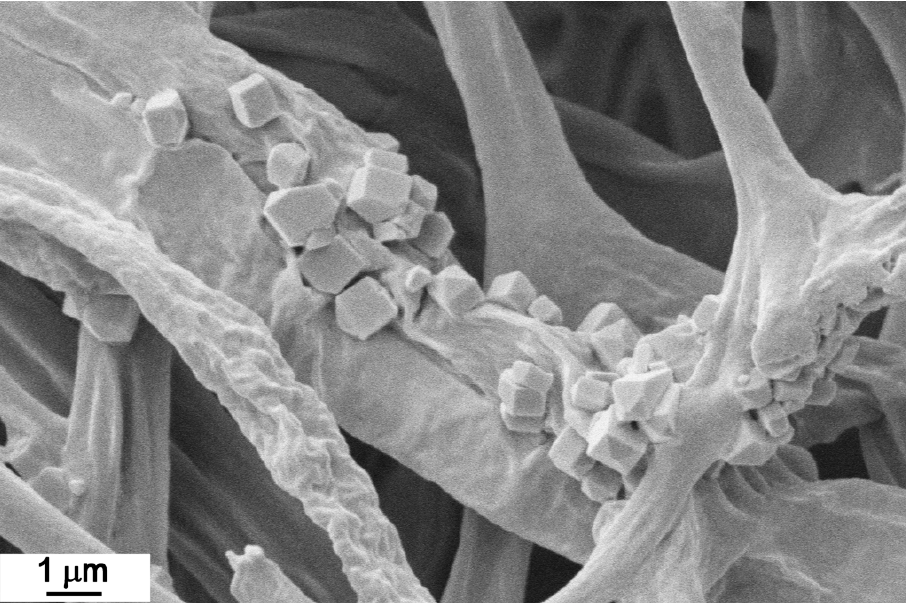
Figure 15. Typical oxalate crystals in Fomes fomentarius (8).